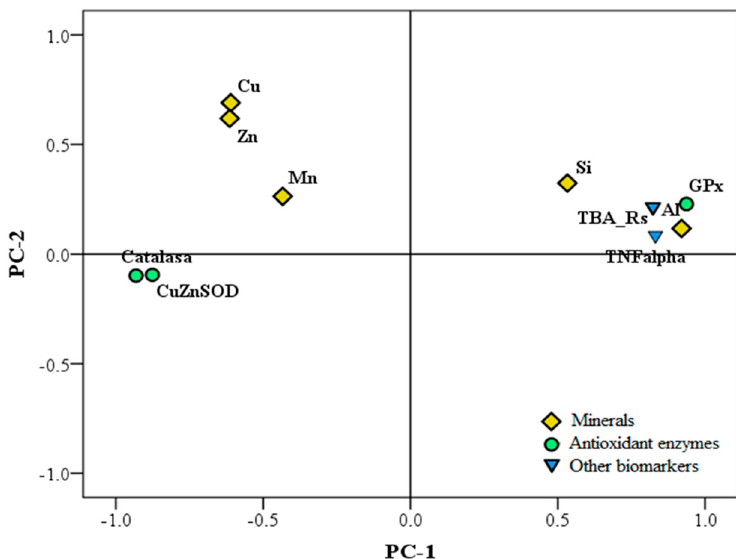
Figure 6. Principal component analysis (PCA) plot of the minerals, oxidation, and inflammation biomarkers of mouse’s brains. The co-administration of aluminum and silicon or beer partially blocked the metal disbalance and reversed the inflammatory and oxidative status in the mouse brain.